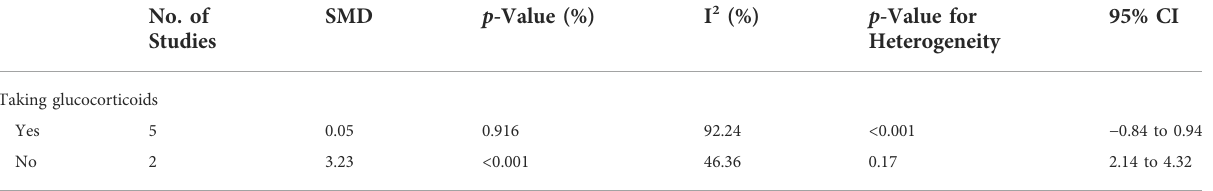
SMD, standardized mean differences.